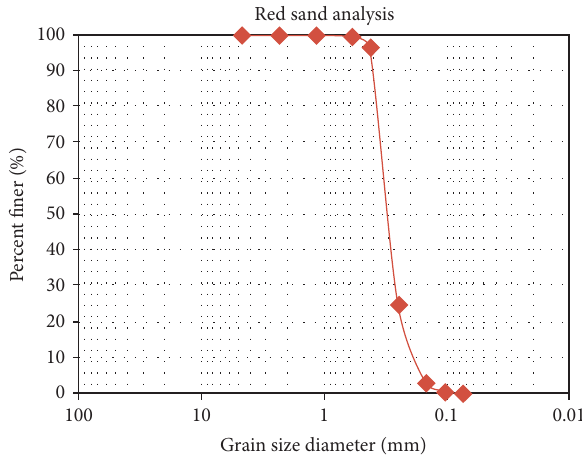
F 3: Grain sand distribution of sand.